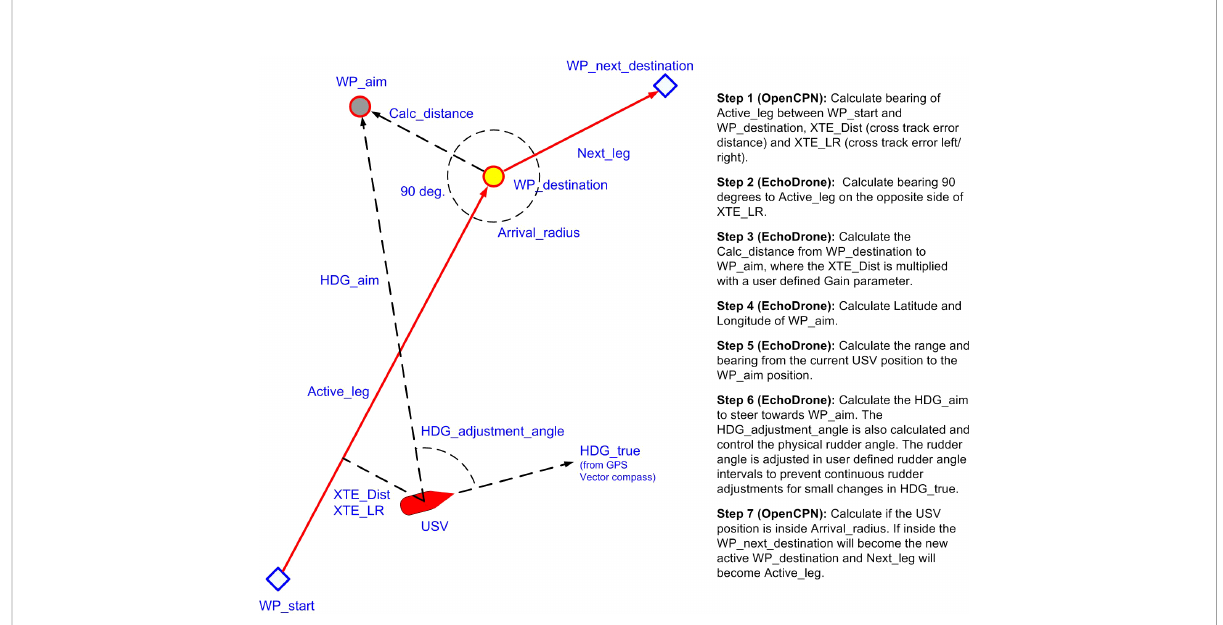
FIGURE 3 Illustration of the autonomous Kayak Drone navigation operation. A survey route with several legs (red arrows) are activated (similar to what is shown in the OpenCPN map). The Kayak Drone (red vessel) is sailing towards the next waypoint destination (WP_destination) marked as a red circle with yellow fi ll. Inactive waypoints are shown as blue diamonds. During operation, a set of calculations are continuously performed by OpenCPN and EchoDrone, and data are exchanged between the two programs. The calculation steps and resulting actions are described on the right side of the Figure. Note that the calculated WP_aim is used to compensate for drift due to wind and currents, which may result in a cross track error distance (XTE_Dist) to the left or right (XTE_LR) of the Active_leg. WP, way point; HDG, heading; XTE_Dist, cross track error (distance from active leg) and whether the USV is to the left or right side of the active leg (XTE_LR).